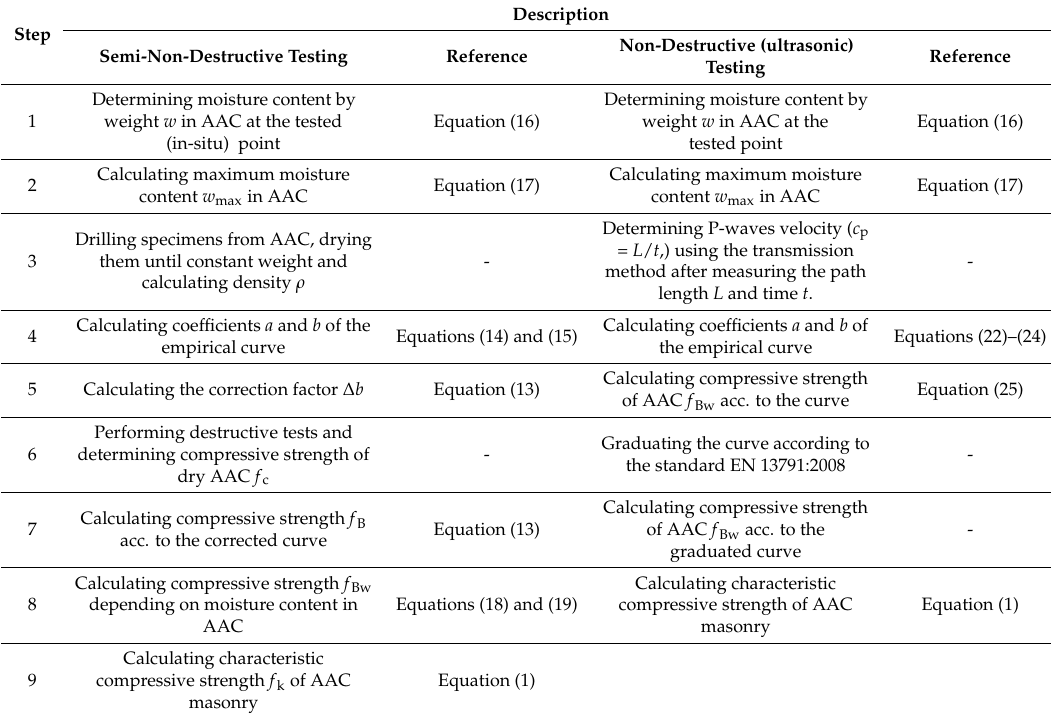
Table 8. Procedure algorithm for determining characteristic compressive strength of masonry with semi-NDT and NDT